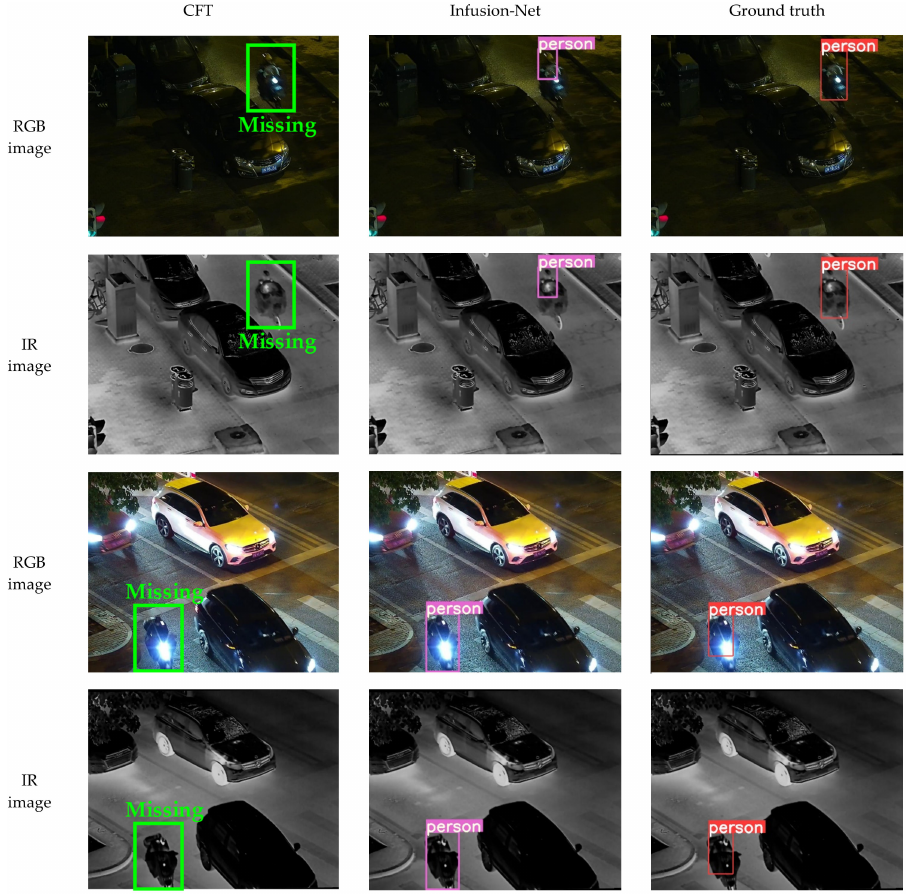
Figure 11. Qualitative comparison of the Infusion-Net results and CFT [25] results on the LLVIP dataset. Green boxes denote missing objects.